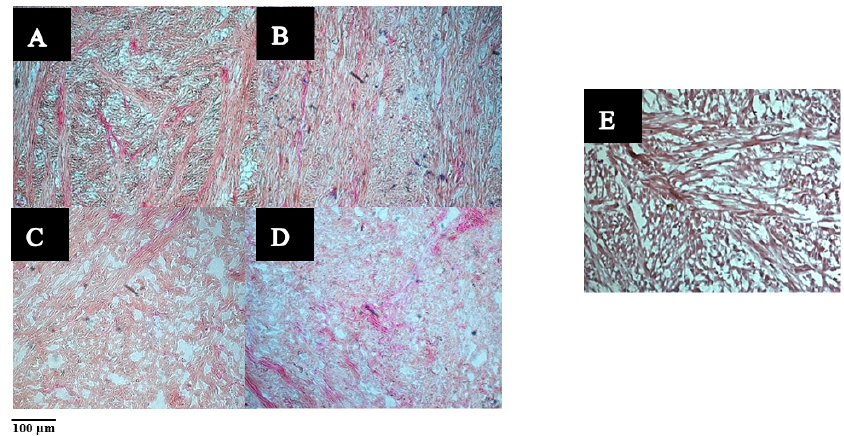
Figure 3. Light micrographs of p ā ua foot muscle tissues stained with Verhoeff-Van Gieson (VVG) staining. ( A – D ) Raw: ( A ) untreated, ( B ) ultrasound in water for 5 min followed by soaking in water at 4 °C for 24 h, ( C ) treated with ( C ) ultrasound in water for 5 min, ( D ) ultrasound for 5 min in 1% actinidin solution, ( E ) untreated cooked control.